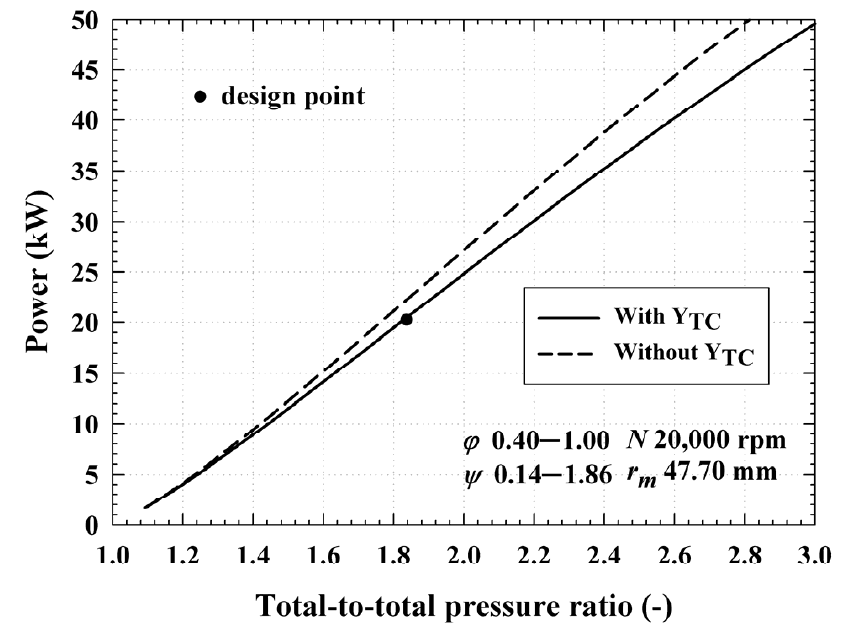
. W t ) with and without the tip clearance loss coefficient ( Y TC ) when ) with and without the tip clearance loss coefficient ( 𝑌 (cid:3047) ) with and without the tip clearance loss coefficient ( 𝑌 (cid:3047)